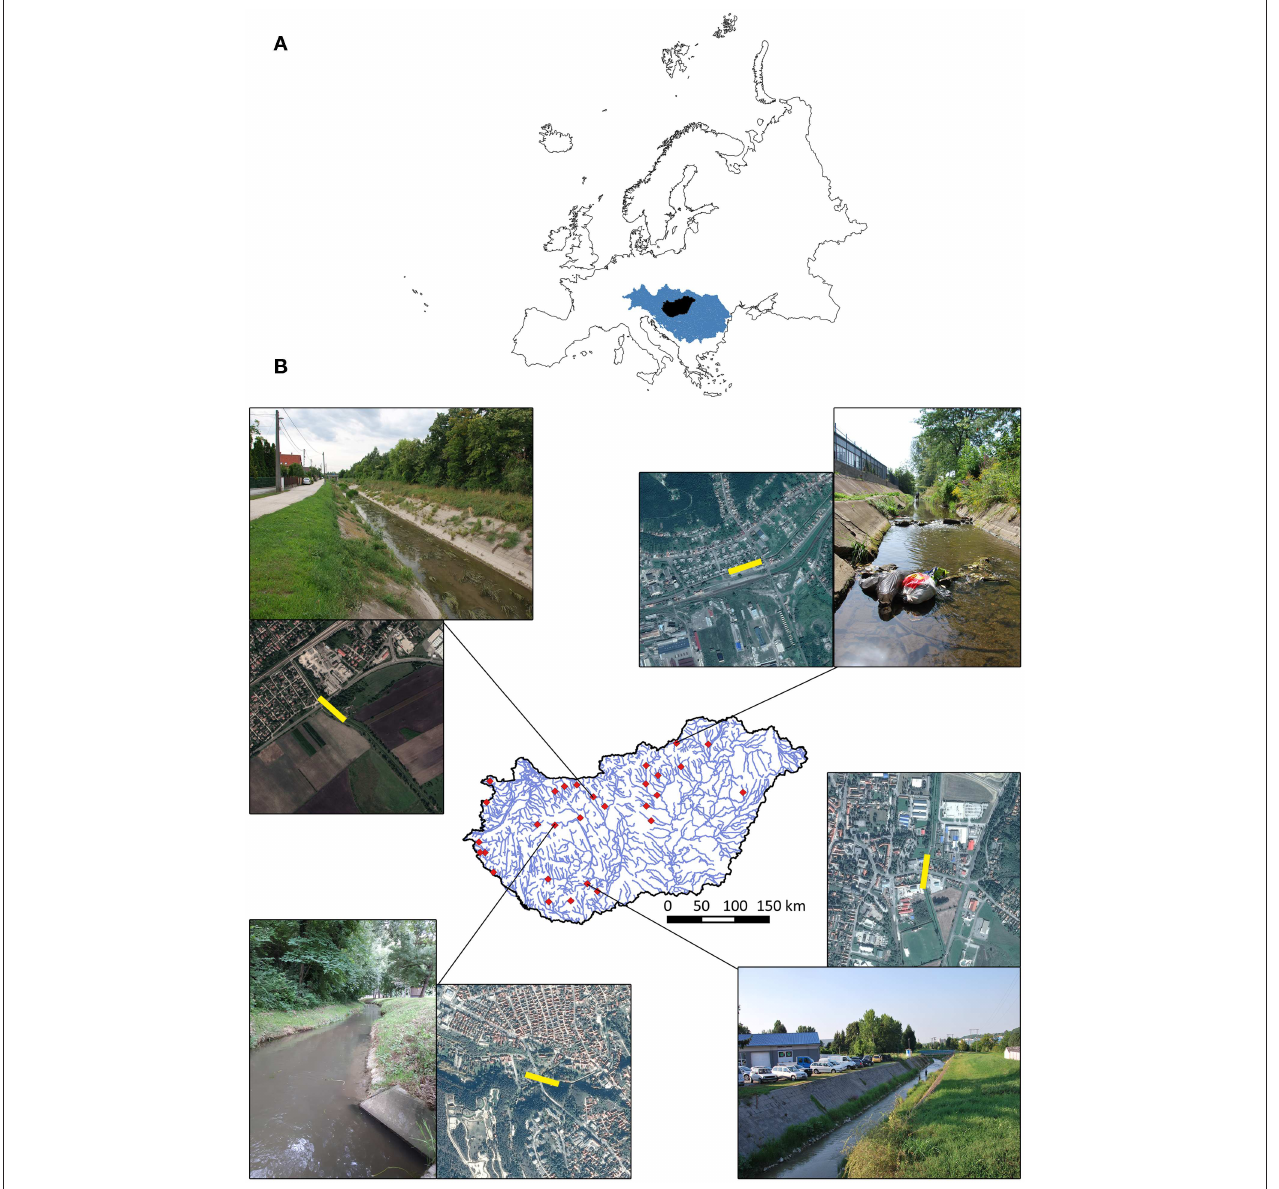
FIGURE 1 | (A) Location of Hungary (black) in the catchment of the Danube River in Europe. (B) Distribution of the sampling sites (red squares) in Hungary and some examples of the studied streams (photos taken during fieldwork are shown) with the satellite pictures from Google Maps. The exact locations of the sampled urbanized sections are indicated by yellow